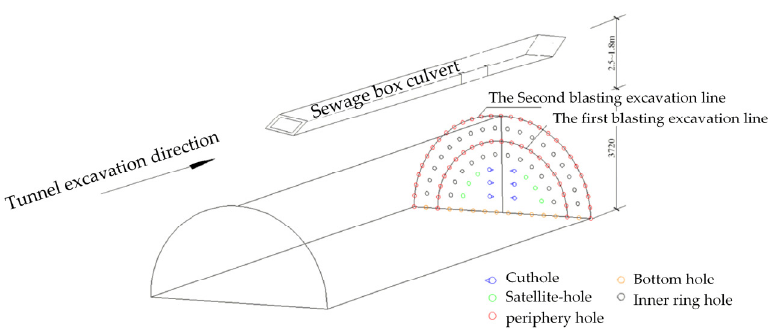
Figure 8. Blast-hole layout diagram of drilling and blasting pattern. Figure 8. Blast ‐ hole layout diagram of drilling and blasting pattern. In the paper, Table 3. The diameter of blast ‐ holes is 42 mm; the diameter of the charges is 32 mm. Table 3. Explosive parameters.